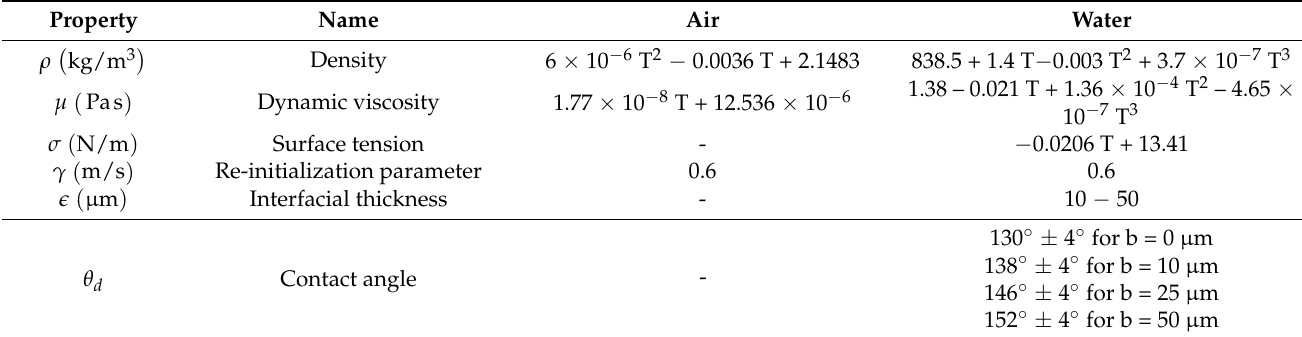
Figure 5. Variation of the normalized wetting diameter obtained from predictions and experiments during spreading and retraction stages for various micro ‐ post spacings: ( a ) hydrophobized flat sur ‐ face b (cid:3404) 0 μ m , ( b ) b (cid:3404) 10 μ m , ( c ) b (cid:3404) 25 μ m , ( d ) b (cid:3404) 50 μ m . Droplet volume is 10 μ L and impact height is 20 mm.